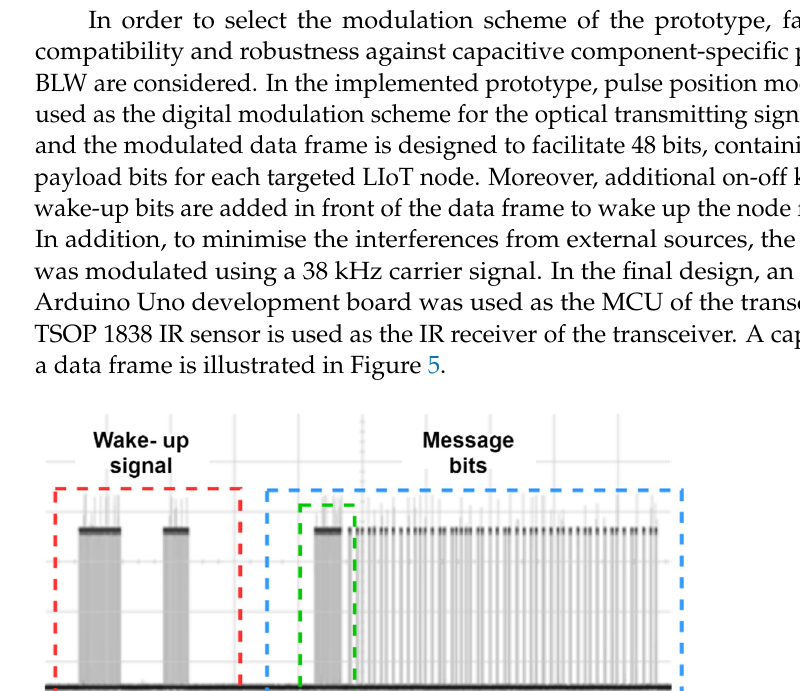
Figure 4. Structure of the transceiver-illumination system.